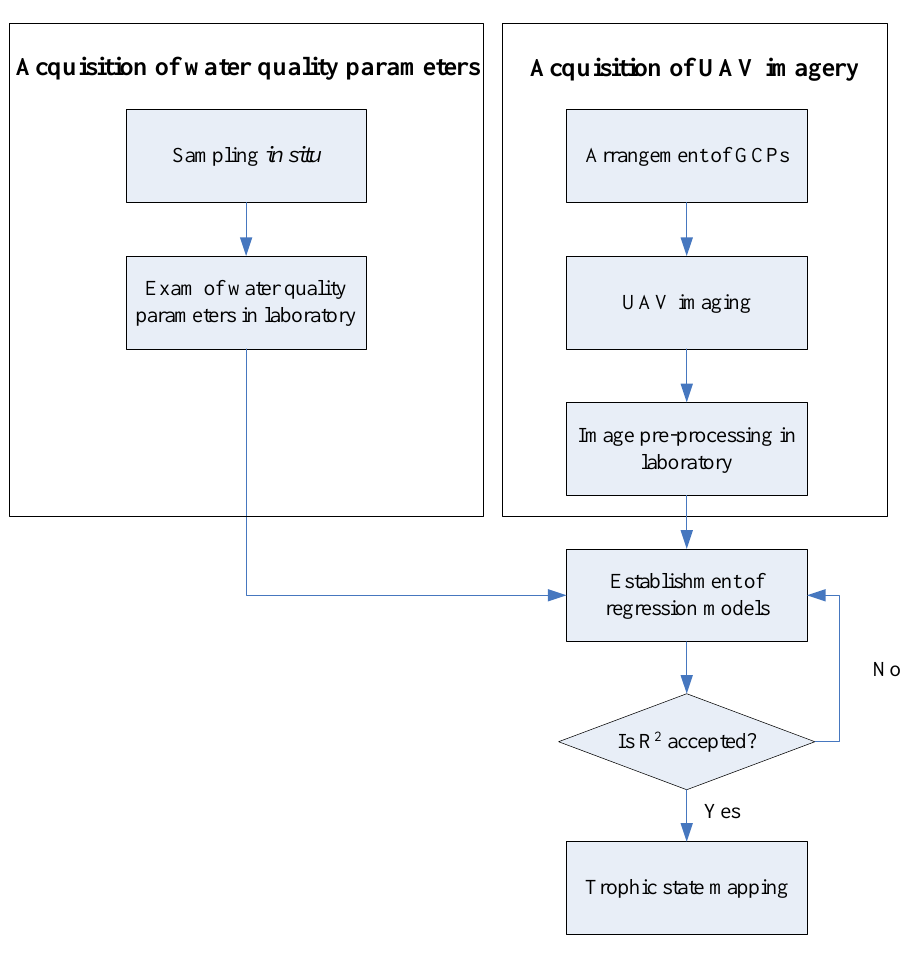
Figure 2. Flowchart of applying UAV multispectral imagery coupled with measurement, in situ , to trophic state mapping of small